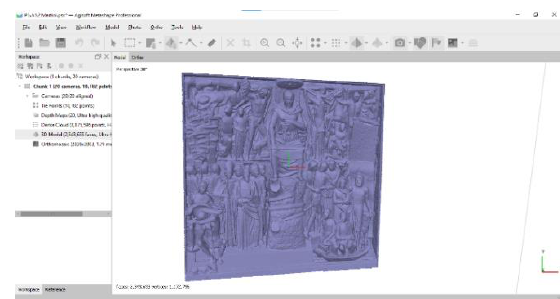
Fig 13. 3D mesh without texture (shaded).